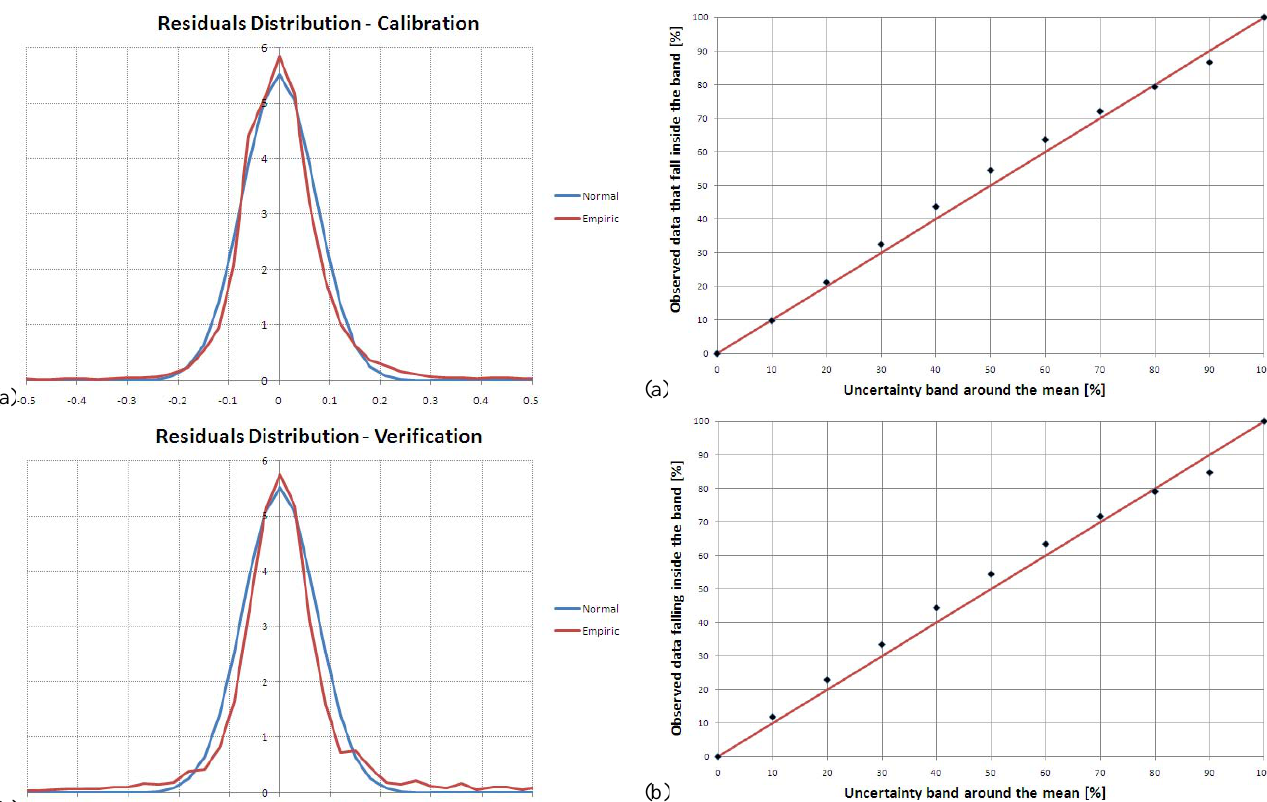
Fig. 20. Percentage of observed data that fall inside the uncertainty band at various probability levels defined with a 10% interval. The red line represents the perfect behaviour. The results were obtained considering the entire calibration (a) and verification (b) periods for the bayesian combination of the three